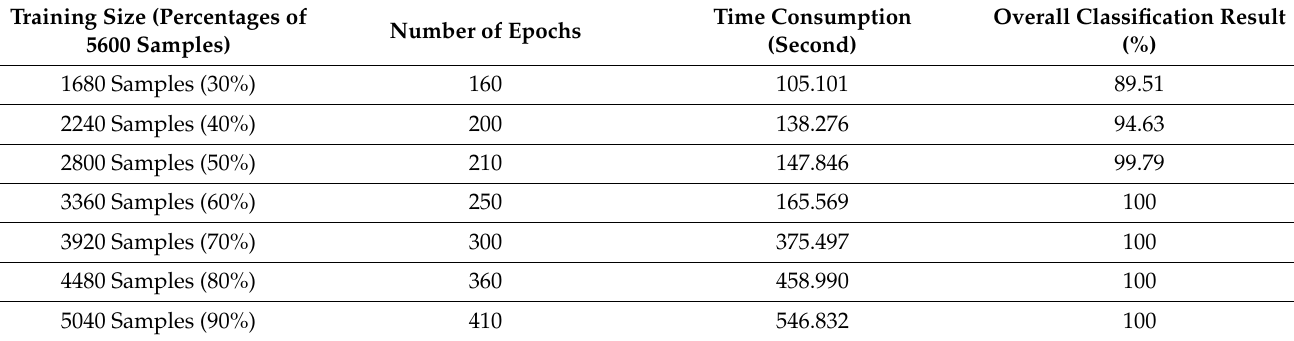
Table 5. The classification accuracy and time consumption for various size of the training